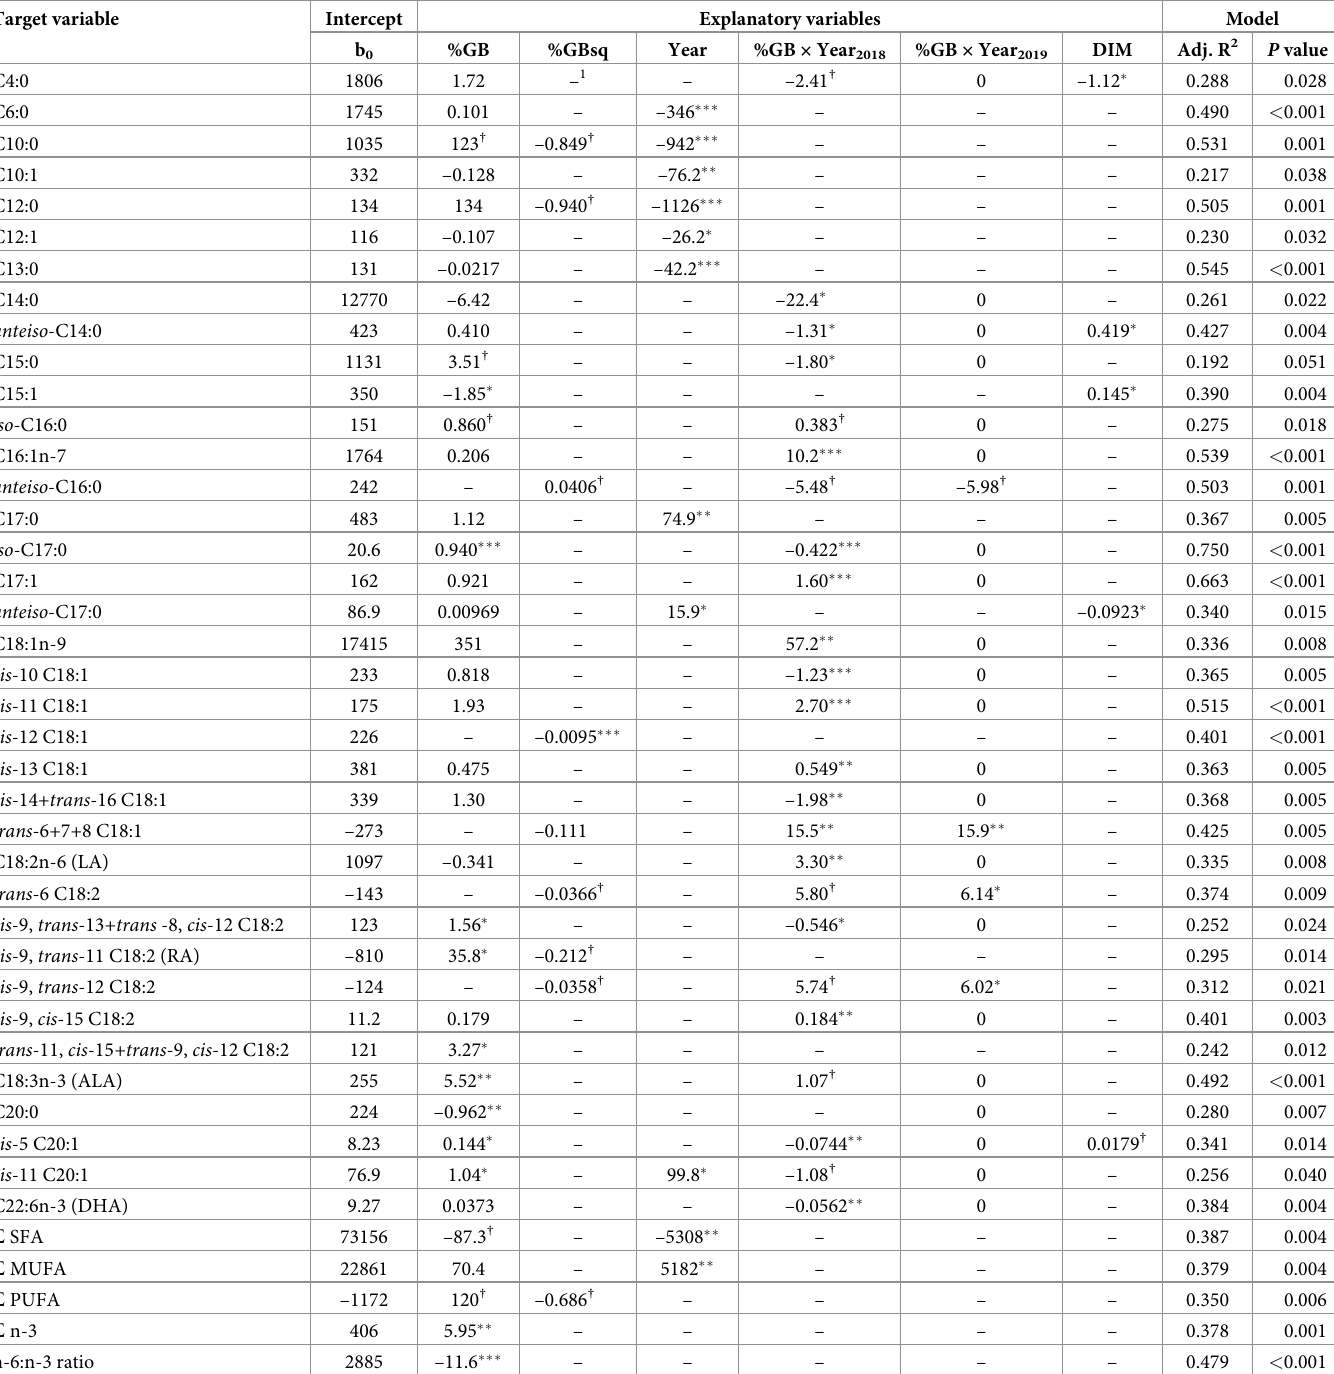
Table 4. Significant model regression coefficients for proportions of individual fatty acids (mg/100g total FAME) in milk analyzed by GC in relation to the percent- age of grassland-based feeds in the diet (%GB) and the year of harvest (n = 11, 2018; n = 11, 2019). Target